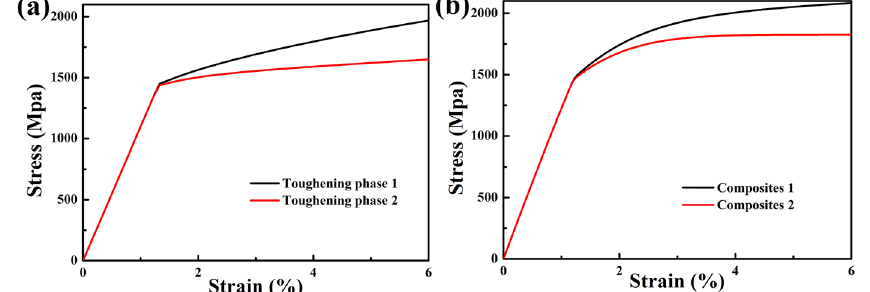
Figure 7. The tensile stress-strain curves from the finite-element model, Fig. 7(a) shows the tensile stress-strain curves for different toughing in-situ dendrites within MGMCs, the black one responses to a work hardening behavior induced by deformation twining and the other one (red one) has softening without TWIP effect. The black curve in Fig. 7(b) represents the composite consisted by toughing phase 1 in Fig. 7(a), and the red curve correspond to the toughing phase 2 in Fig.